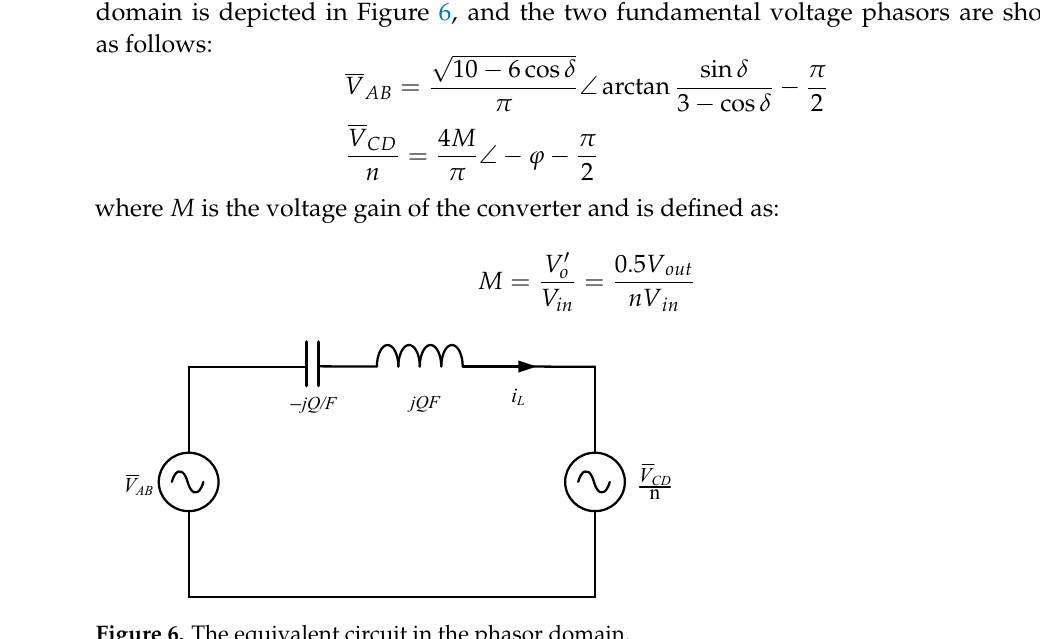
Figure 6. The equivalent circuit in the phasor